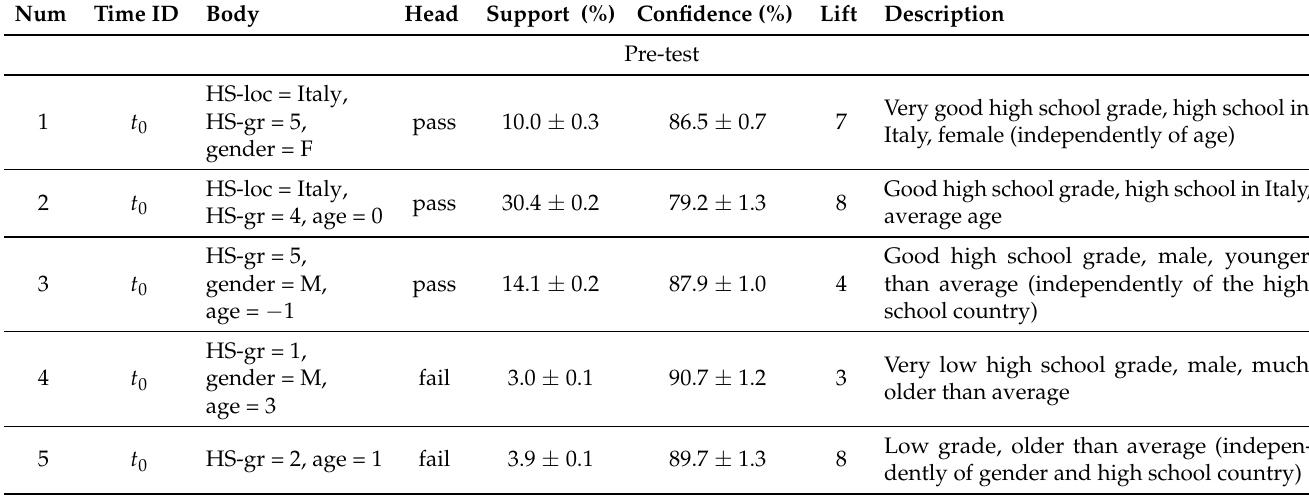
Table 6. High-quality single-feature rules mined from the MA datasets including only SSC features. minsup = 1%, minconf = 50%, mincorr = 2. Support and confidence values of each of the selected rules are averaged over the 5 cross- validation folds (average and standard deviation are specified).